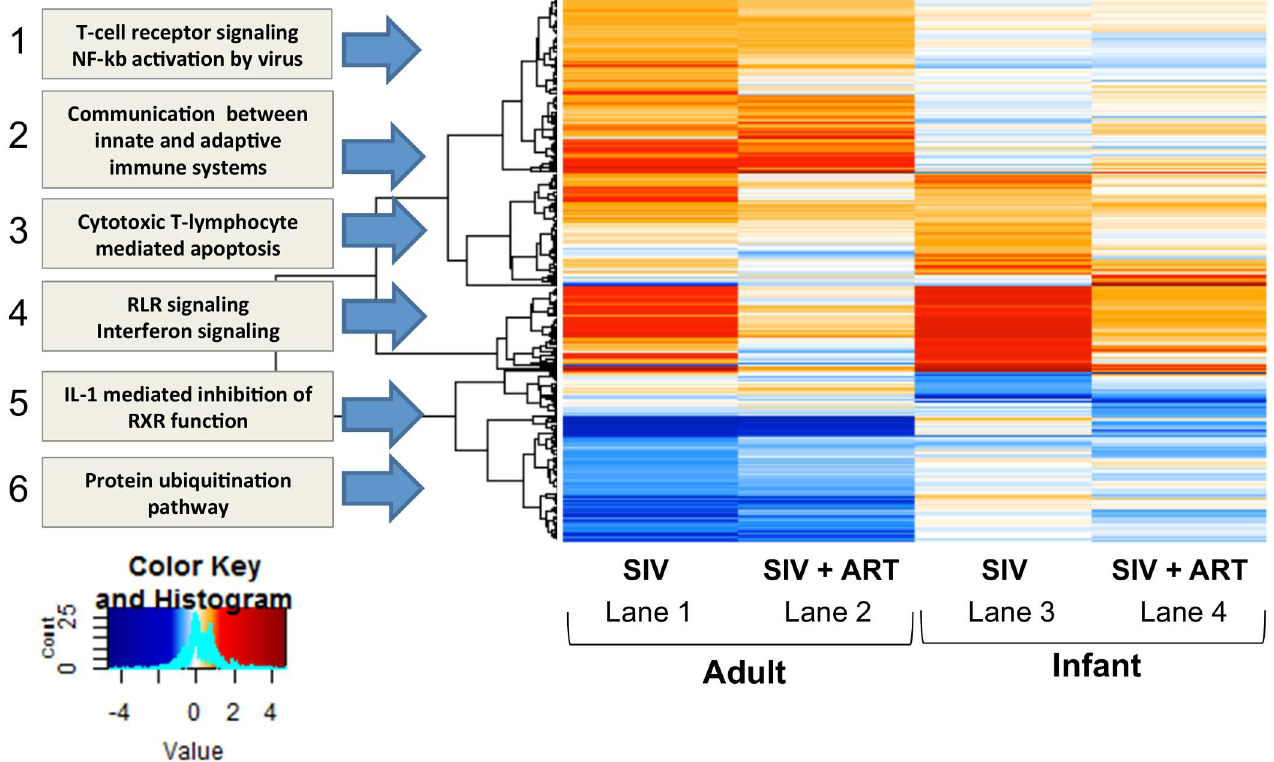
Fig 10. Heatmap of the global liver transcriptomic signature. The liver transcriptome was evaluated by microarray analysis. Treatment groups (SIV+ or SIV + cART) were compared against age-matched uninfected macaques to determine differentially expressed genes using the limma package in R/bioconductor. Co-expression analysis was performed using weighted gene coexpression network analysis (WGCNA) and heatmap packages in R/bioconductor using cutoffs of 1.5 fold change and 0.05 adjusted pvalues in at least one condition. Gene networks (modules) involved in immune response and inflammation are upregulated in SIV-infected macaques with antiviral RLR and interferon signaling highly upregulated in both adults and infants.